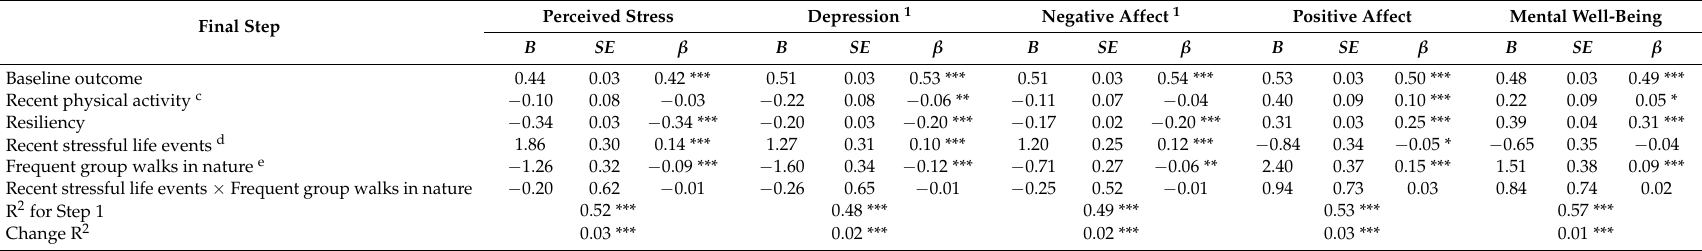
Table 5. Moderation results assessing frequent group walks in nature, recent stressful life events, and the interaction term on perceived stress, depression, negative affect, positive affect, and mental well-being. Frequent Nature Group Walkers subsample a ( n = 930 b ).